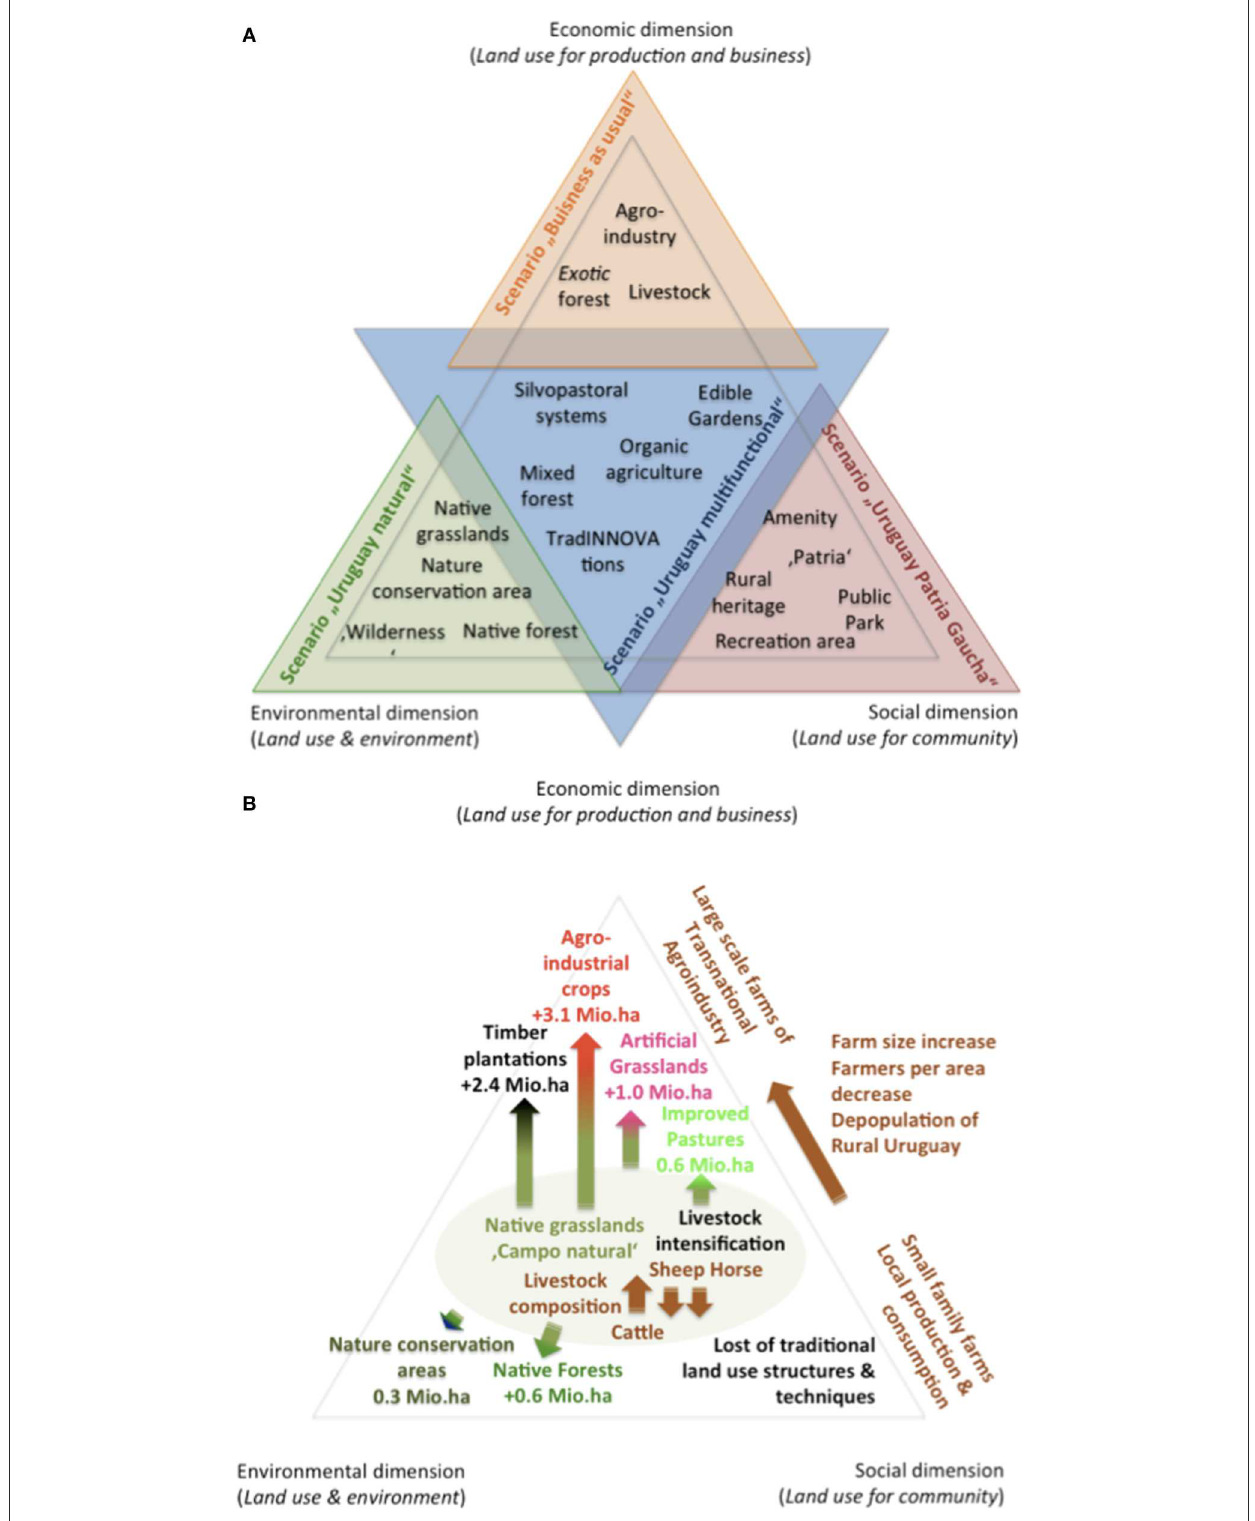
FIGURE4 (A) Economic, environmental and social dimensions of rural landscape with relevant land-use types and developmental scenarios (i.e. ‘Business as usual’, ‘Uruguay natural’, ‘Uruguay Patria Gaucha’ and ‘Uruguay multifunctional’). (B) Pathways of land-use change during the last decades in Uruguay are driven mainly by increasing economic profits of transnational silvi- and agroindustry, at the expense of local family farms with traditional grassland-use modes and techniques, accompanied by rural depopulation and the aging of rural society. Public nature protection efforts to achieve an increase of native forest cover and the establishment of nature protection areas have mainly focused on forests, but not on natural